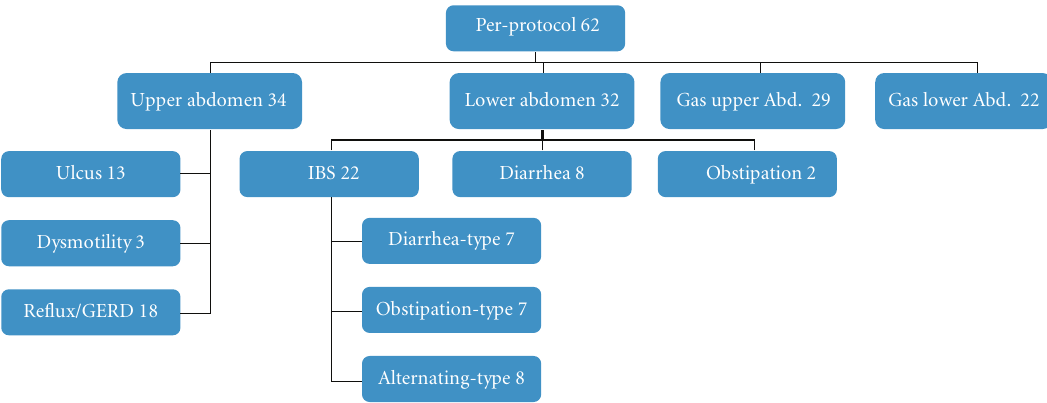
Figure 3: Patients subgroups according their predominant symptoms, patient numbers ( n